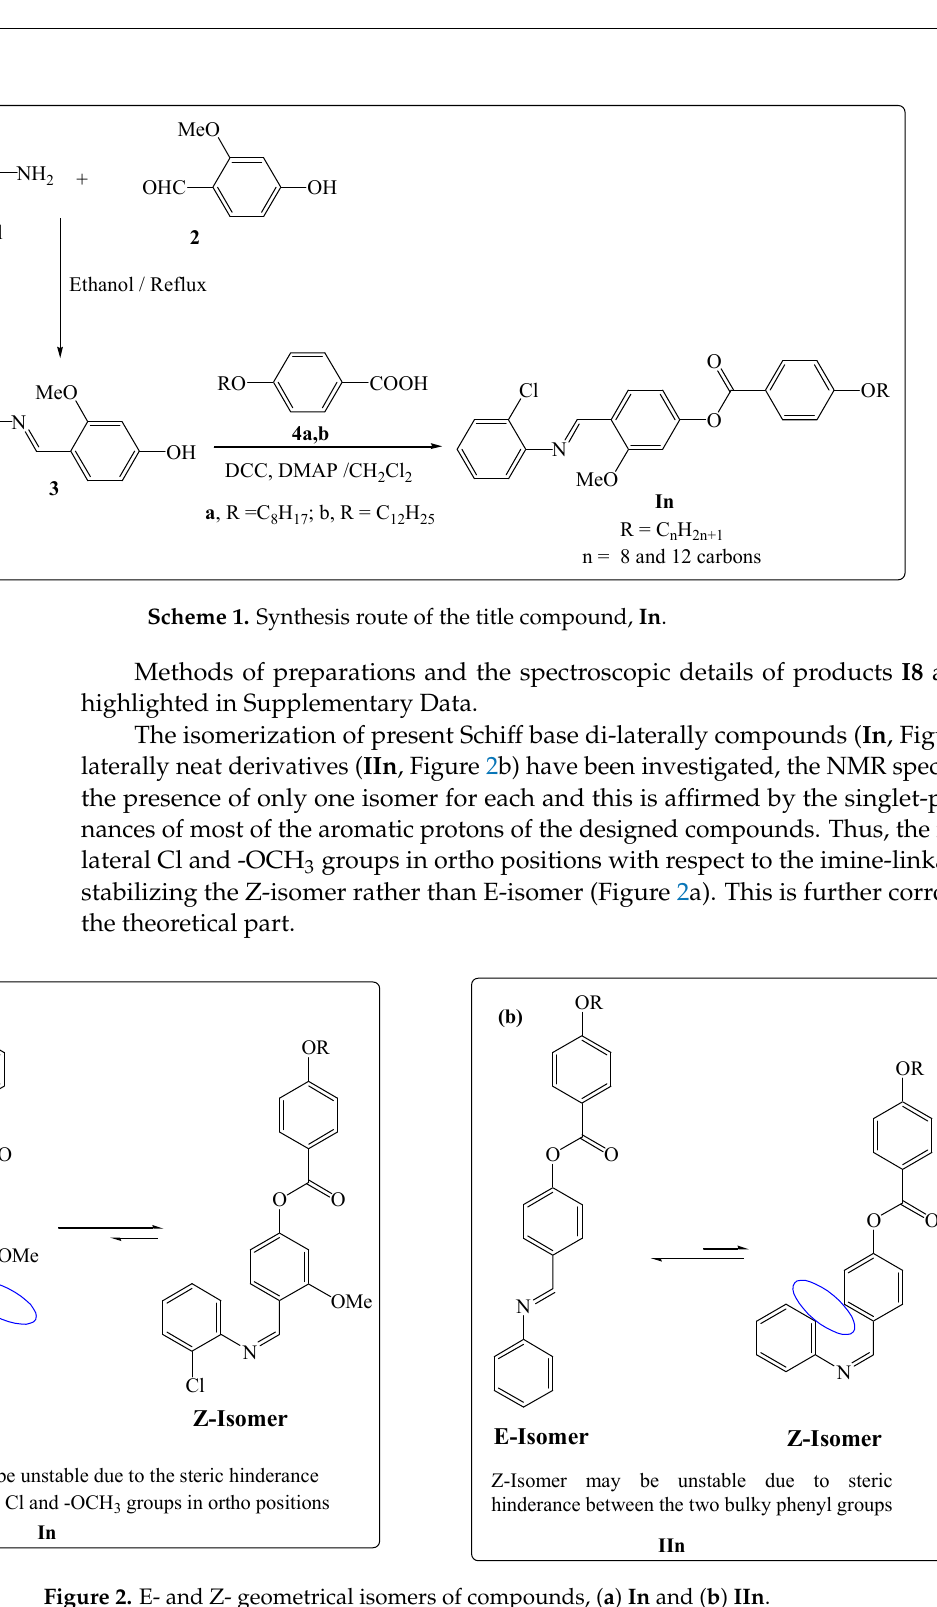
Figure 2. E- and Z- geometrical isomers of compounds, ( a ) In and ( b ) IIn .